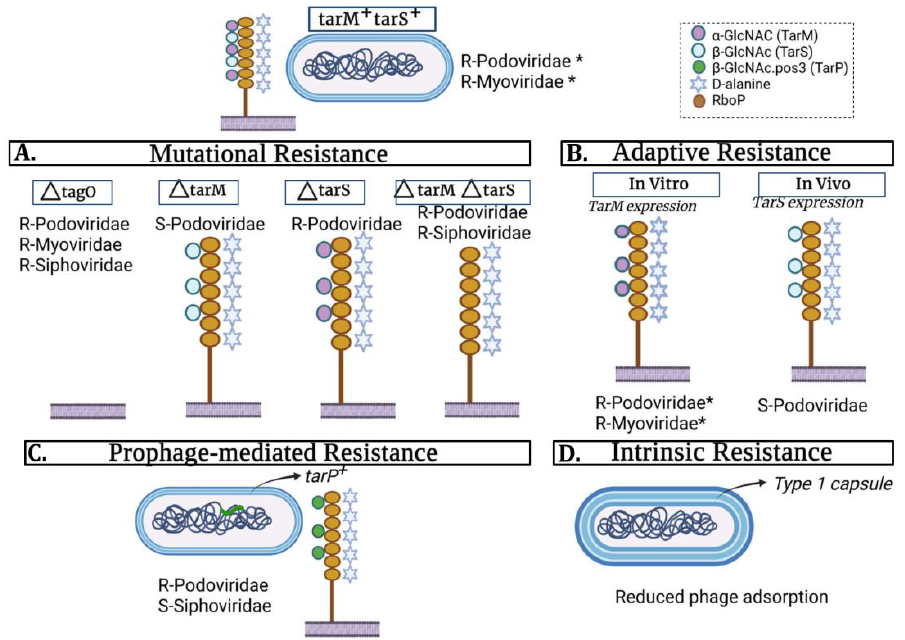
Figure 2. Different types of phage resistance mechanisms affecting WTA structure. The drawing on top represents a hypothetical wild-type strain, which may then display differences in its susceptibility to different phages due to mutational resistance ( A ), adaptive resistance ( B ) or prophage-mediated resistance ( C ). Additionally, some strains may exhibit reduced adsorption of all types of phages if they have a type 1 or 2 capsule ( D ). R-: resistance to a family of phages, S-: susceptibility to a family of phages. *, α -GlcNAc can mask the WTA backbone and/or β -GlcNAc, which has an impact on the attachment of certain bacteriophages. The box in the top right is the legend for the different symbols of WTA components and modifications.